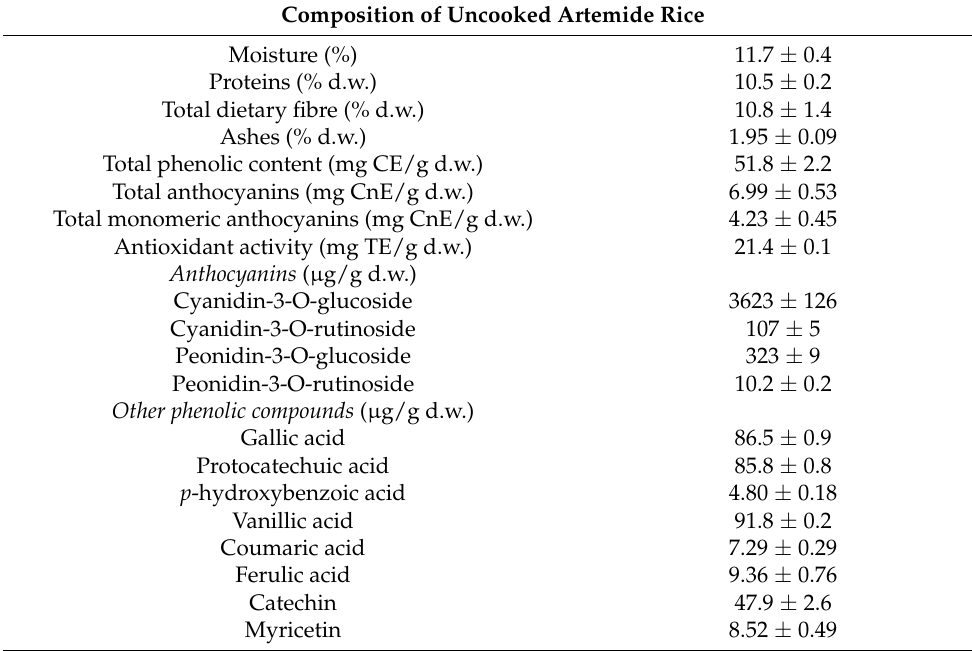
Table 2. Proximate composition, total phenolic content (mg CE/g d.w.), total antioxidant activity (mg TE/g d.w.), anthocyanins (mg Cn-3-Glu/g d.w.) and individual phenolic compounds ( µ g/g d.w.) determined in uncooked Artemide rice. The results are expressed as mean ± standard deviation. Composition of Uncooked Artemide Rice Moisture (%) Proteins (% d.w.) Total dietary fibre (% d.w.) Ashes (% d.w.) Total phenolic content (mg CE/g d.w.) Total anthocyanins (mg CnE/g d.w.) Total monomeric anthocyanins (mg CnE/g d.w.) Antioxidant activity (mg TE/g